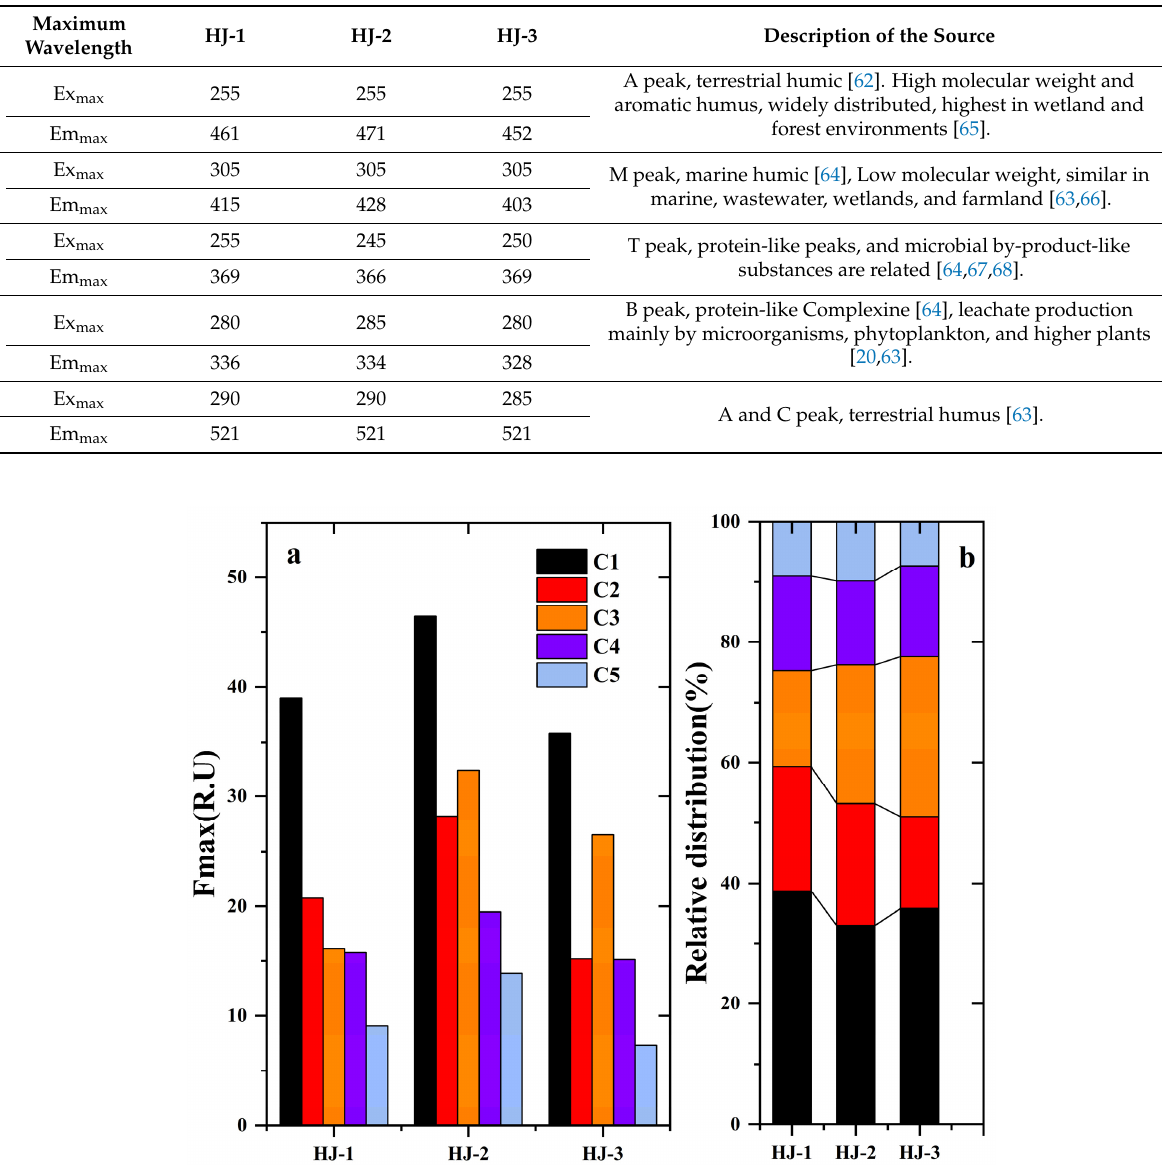
Table 4. Types of DOM fluorescent fractions in fissured soil.